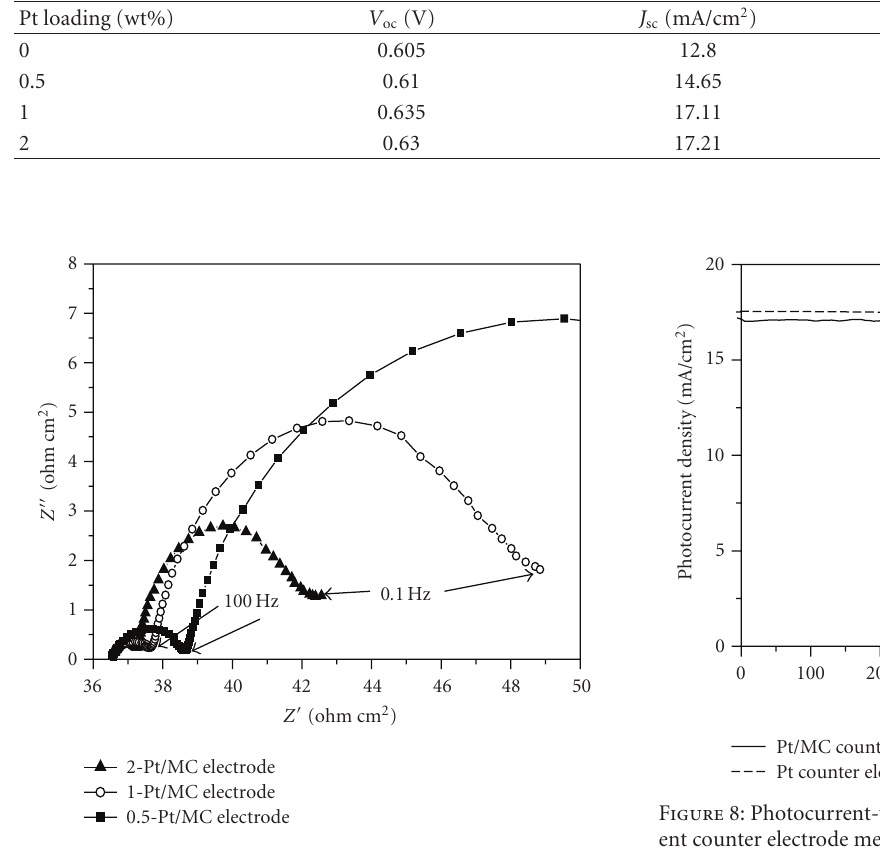
Figure 6: Electrochemical impedance spectra of the symmetric thin-layer cell consisting of two identical Pt/MC electrodes taken at zero bias, ac amplitude 10mV, the electrolyte containing 0.5 M KI/0.05M I 2 in the mixture of EC and PC (EC:PC = 2:8 by volume).